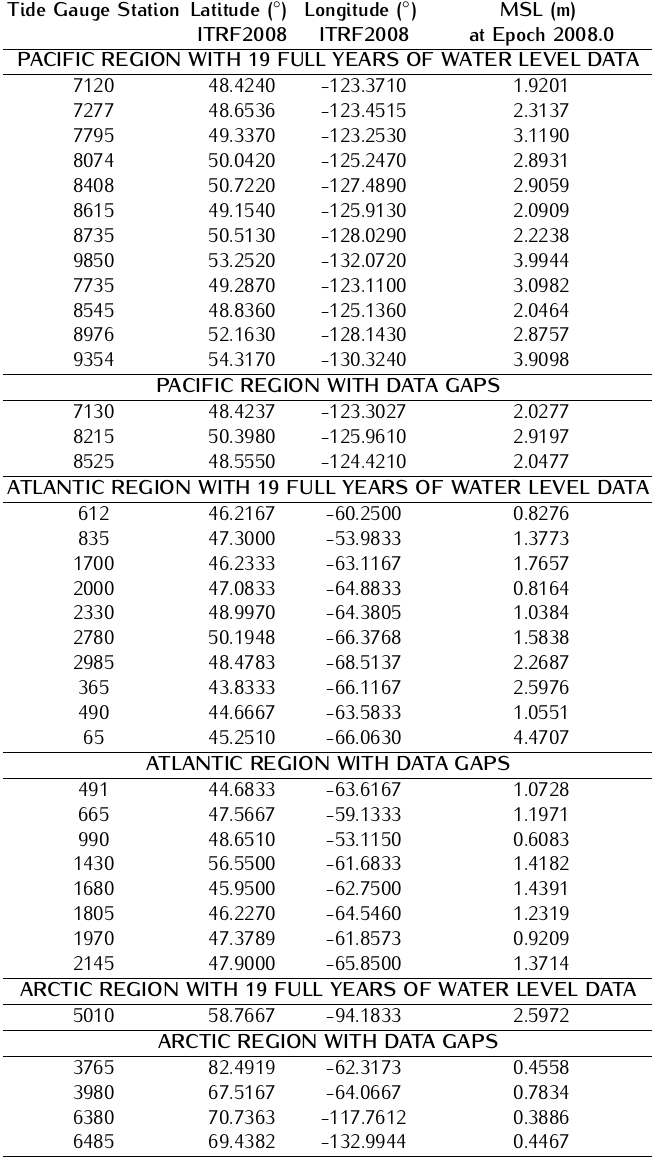
Table 1. Canadian tide gauge stations and local mean sea